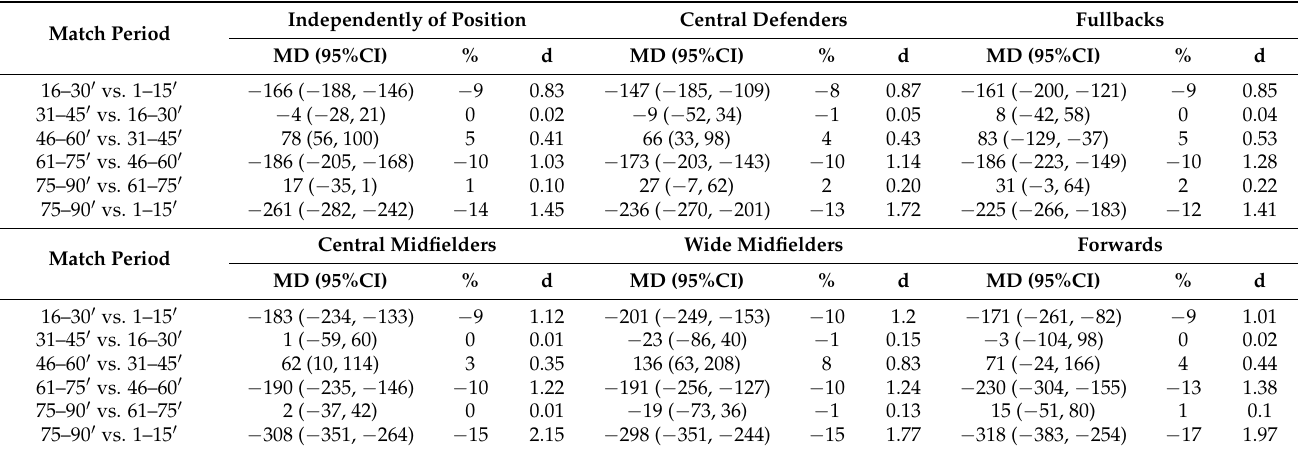
Table 3. Differences in total distance covered between specific 15-min match